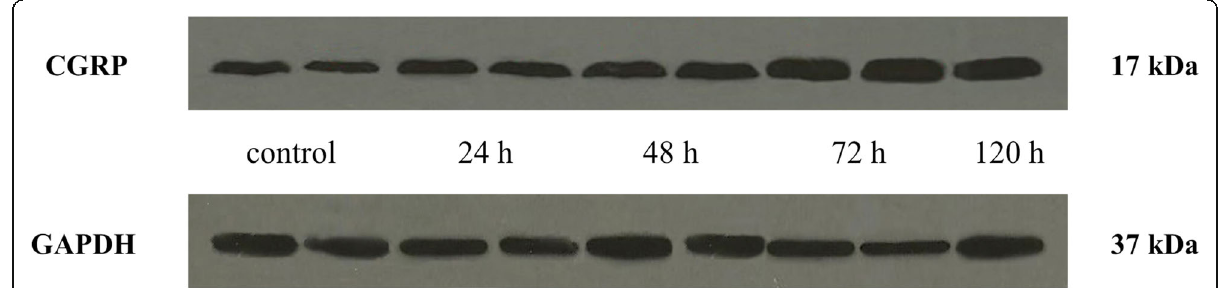
Fig. 4 Western blot of CGRP and GAPDH expression in the